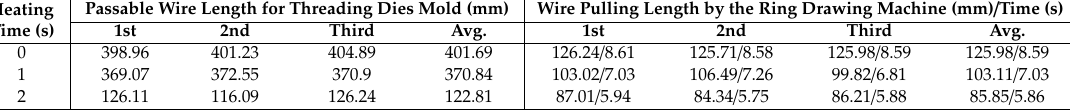
Table 19. Results based on wire pulling speed: k8(14.66 mm / s).